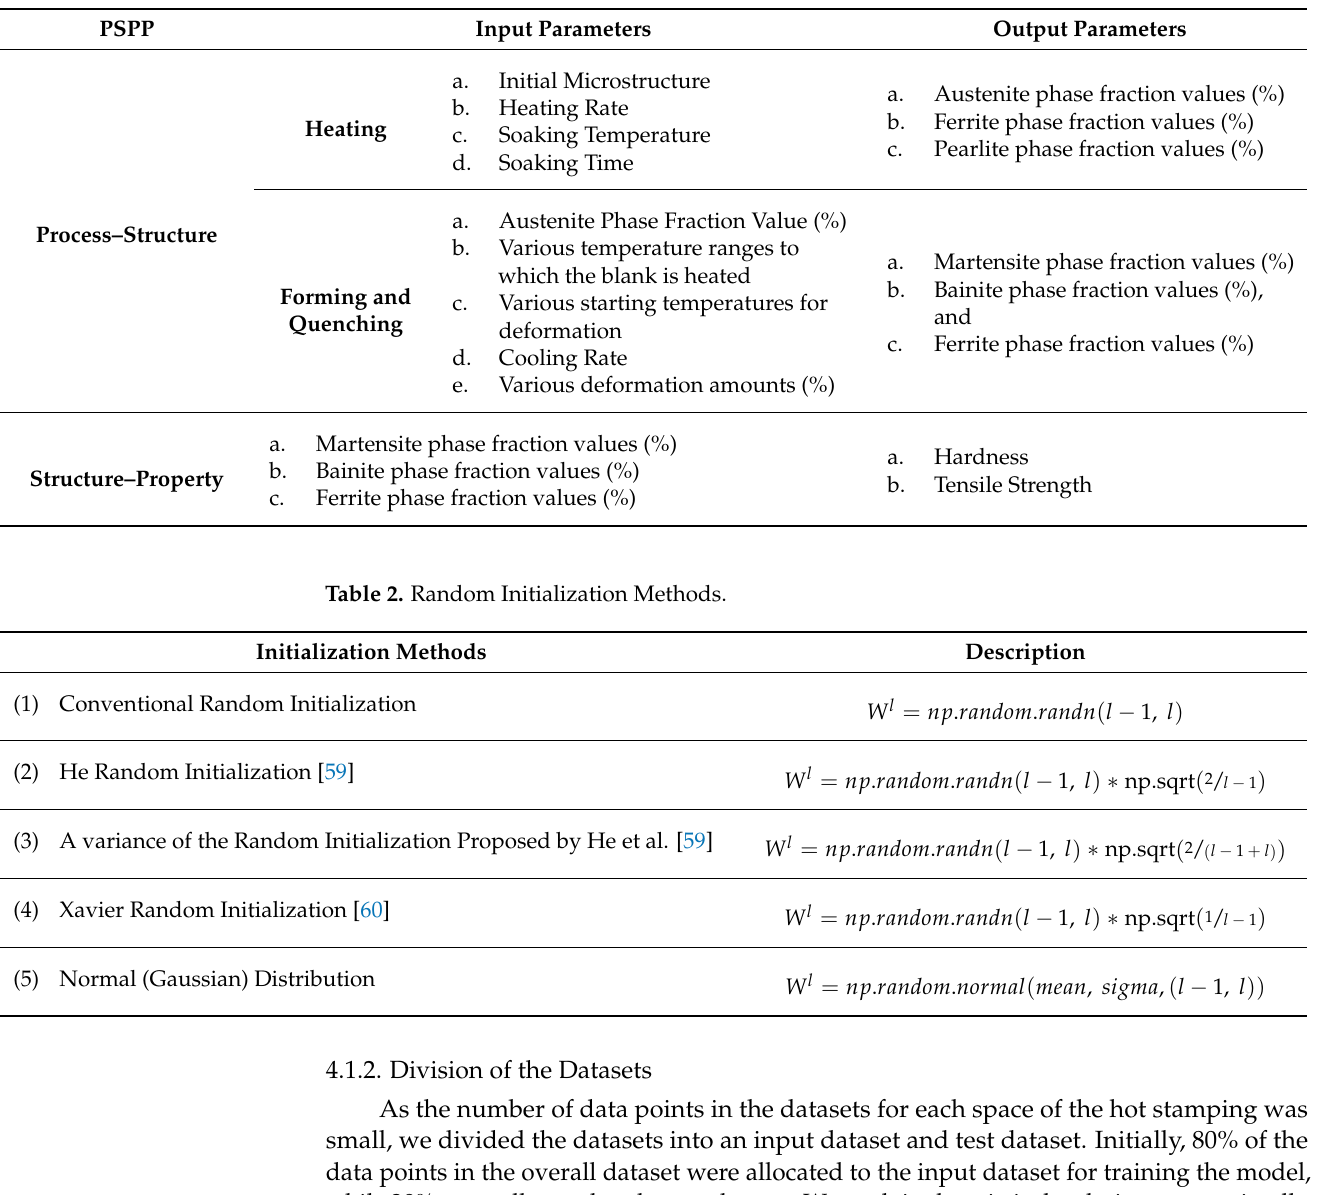
Table 1. Parameters involved in the PSPP chain of the Hot Stamping Process.